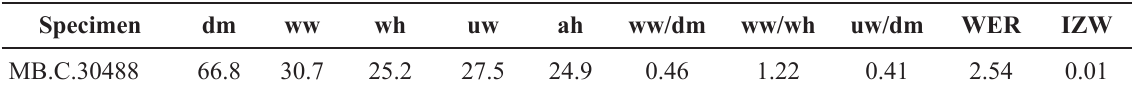
Table 19. Conch dimensions (in mm) and ratios of Lispoceras sp.